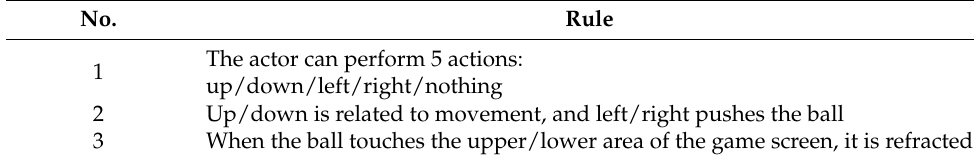
Figure 4. Architecture of the proposed multi-agent N-DQN. 3.1.1. Hierarchization and Policy N-DQN is defined by being largely divided into a main layer and a sublayer. First, the sublayer is defined as an actor that actually performs an action, obtains rewards and experiences, and stores them in memory, and the main layer extracts better data from the learning data (Episode). It controls the behavior of the sublayers through policies, while managing actual learning. Looking at the example in Figure 4, each of the four sublayers